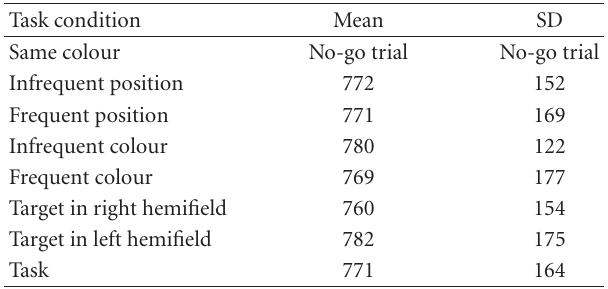
Table 5: Mean amplitude ( µ V) for components of interest and their level of